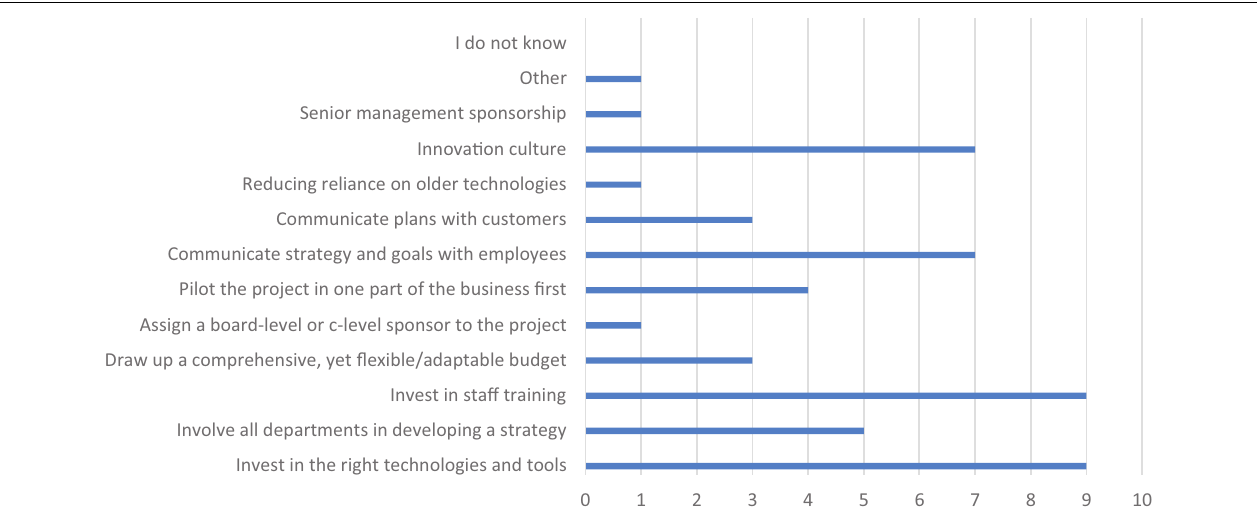
FIGURE 3 | The most important steps to enable the successful introduction of disruptive innovations ( n = 49; source: